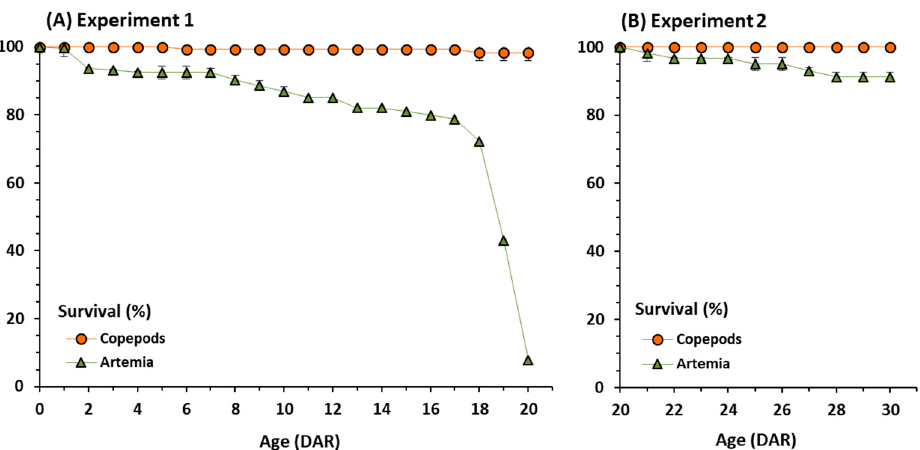
Figure 2. Survival (%) in juvenile seahorses Hippocampus guttulatus fed on copepods or Artemia over each experimental period. ( A )—Experiment 1: Juveniles fed on Artemia (nauplii and metanauplii) or copepods until 20 DAR; ( B )—Experiment 2: Juveniles fed on copepods in Experiment 1 until 20 DAR and subsequently fed on Artemia (nauplii and metanauplii) or copepods until 30 DAR. Means and standard deviations are represented.